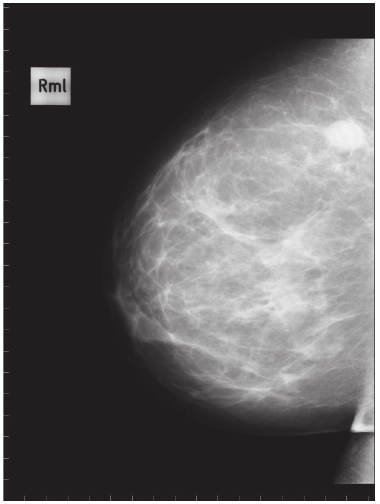
Figure 1: Mid-lateral mammogram of the right breast shown in the upper outer quadrant in a radiopaque mass with margins irregular and speculated.